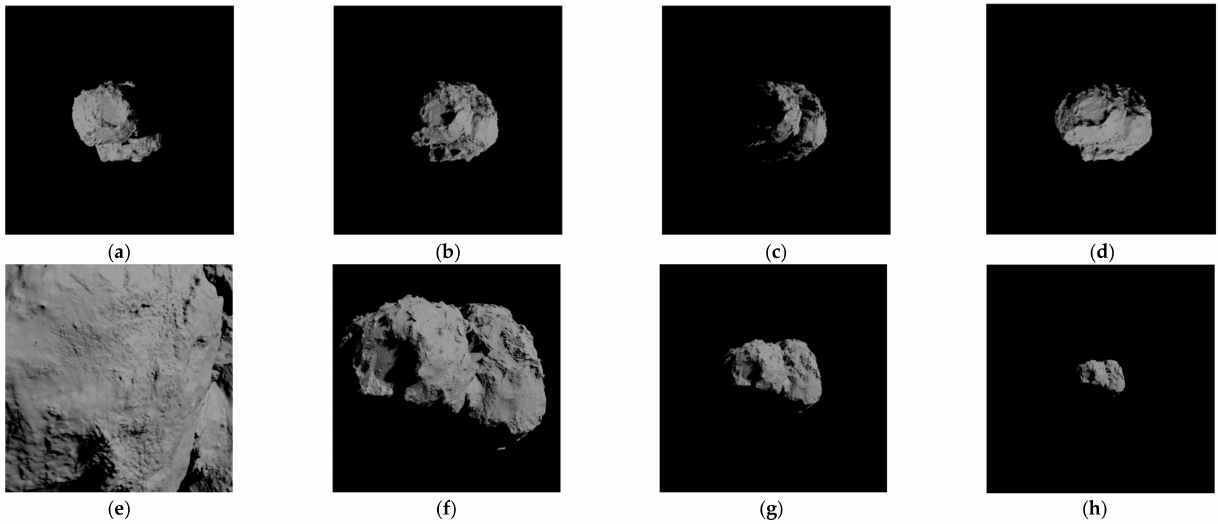
Figure 9. Images Generated Under Different Lighting and Scale Scenes. ( a ) light A, ( b ) light B, ( c ) light C, ( d ) light D, ( e ) 4 km, ( f ) 10 km, ( g ) 20 km, ( h ) 40 km.